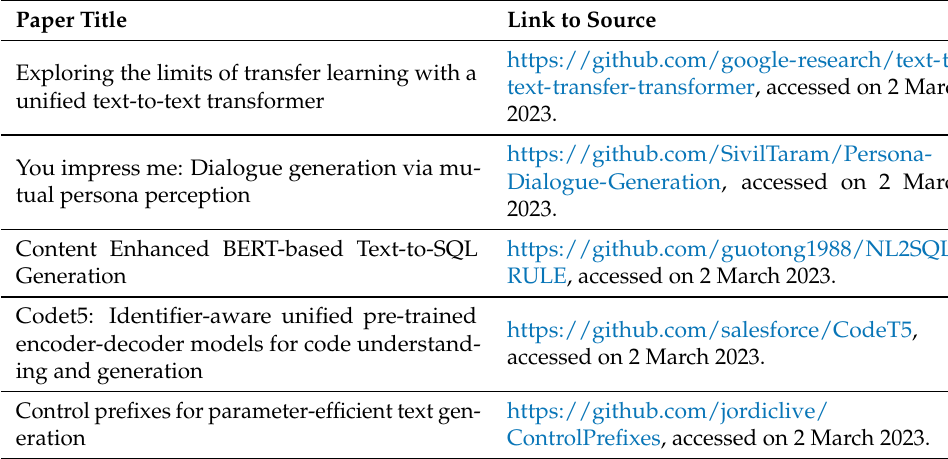
Table 5. Source code links for Text